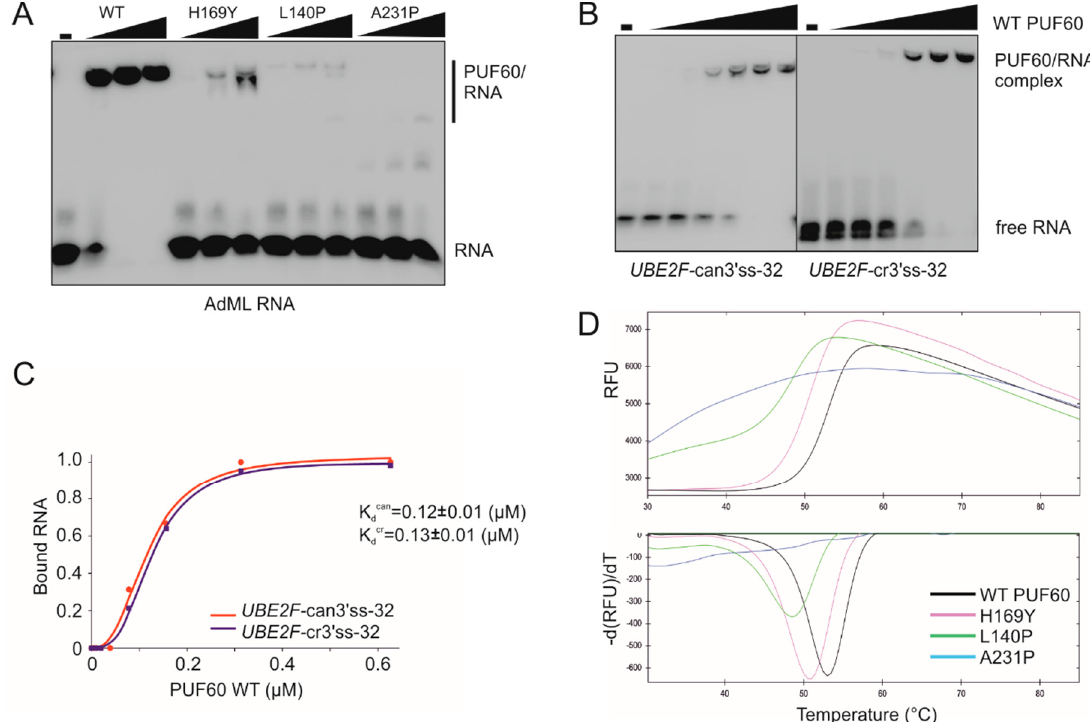
Figure 7. Cancer-associated PUF60 RRM substitutions impair RNA binding and denaturation profiles. ( A ) Impaired binding of PUF60 with RRM substitutions to the AdML RNA. Concentrations of recombinant proteins were 0.14, 0.42 and 1.25 µ M. The AdML oligoribonucleotide sequence is in Table 1. ( B ) In vitro binding of WT PUF60 to canonical and cryptic 3 ′ ss of UBE2F exon 5. Concentrations of recombinant PUF60 were 19.5, 39, 78, 156, 312 and 626 nM. RNA probes (bottom) are shown in Table 1. Biotin-labeled RNAs in panels A and B were at 15 nM. ( C ) Graphical representation of bound fractions with mean K d values (±SD). The Hill coefficients were 2.6 ± 0.3 (can) and 3.0 ± 0.2 (cr). ( D ) Thermal denaturation profiles of PUF60 RRM mutants determined by DSF. The hierarchy in AdML EMSA signals for functional PUF60 mutants (WT>H169Y>L140P>A231P) was mirrored by DSF, with T m of H169Y reduced by ~2 °C and T m of